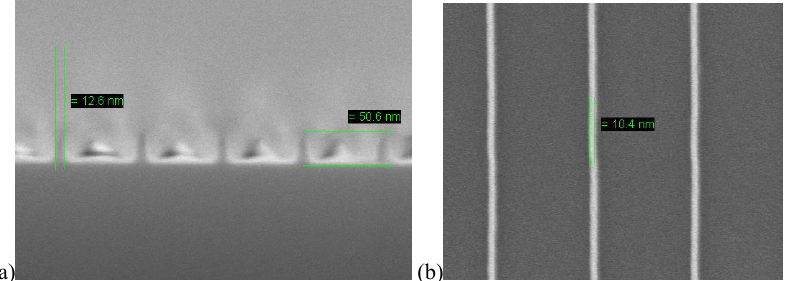
Fig. 1. (a) Cross-sectional SEM of HSQ 12 nm lines with 120 nm spaces in exposed 50 nm thick resist at 30 keV. (b) top view image.